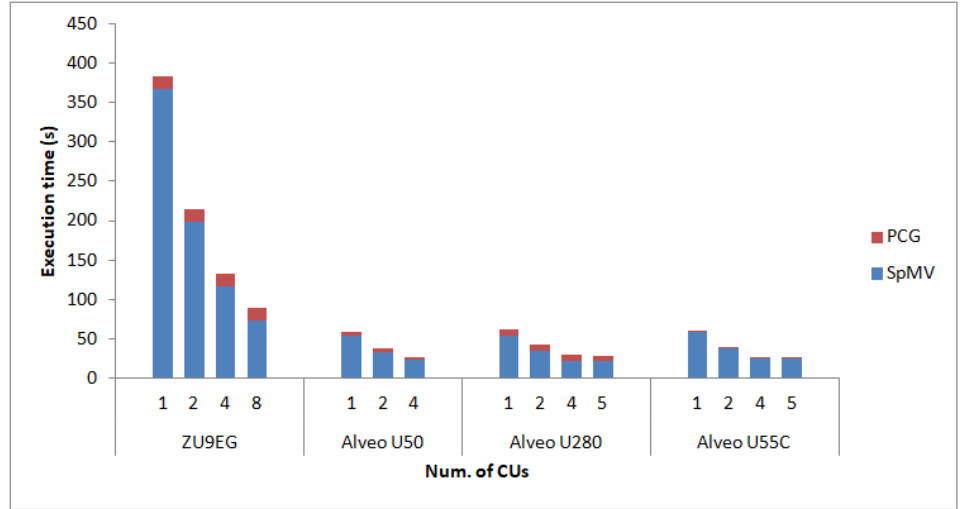
Figure 3. Test case Cube_246389—execution time of 100 iterations of PCG on different hardware varying the number of CUs. The time of the PCG and the corresponding SpMV products are highlighted in red and blue,